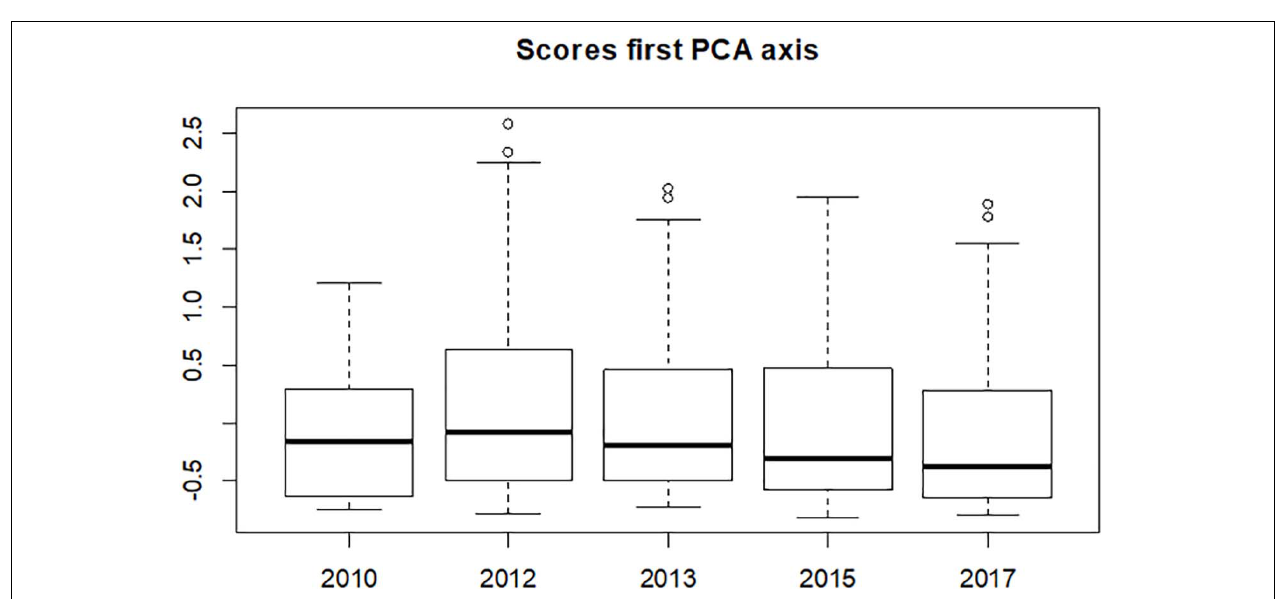
FIGURE 5 | Distribution of the samples’ scores on the first axis of the PCA for the year before the construction of the Sand Motor (2010) and four years after the construction.